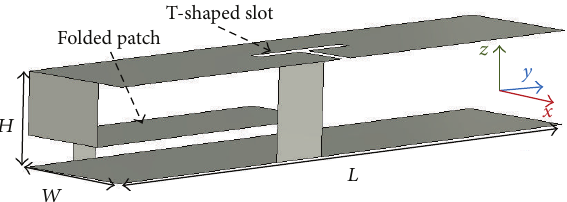
Figure 5: The inclusion of a T-shaped slot as well as a folded patch resultsinawideimpedancebandwidthinthePIFApresentedin[15].